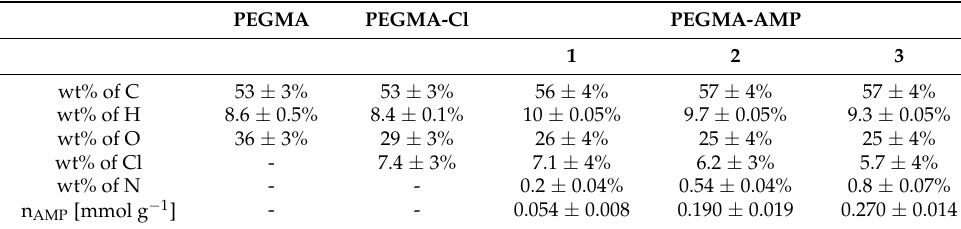
Table 1. Elemental composition and amine site loading (n AMP ) of PEGMA, PEGMA-Cl and three batches of PEGMA-AMP (determined by CHN elemental